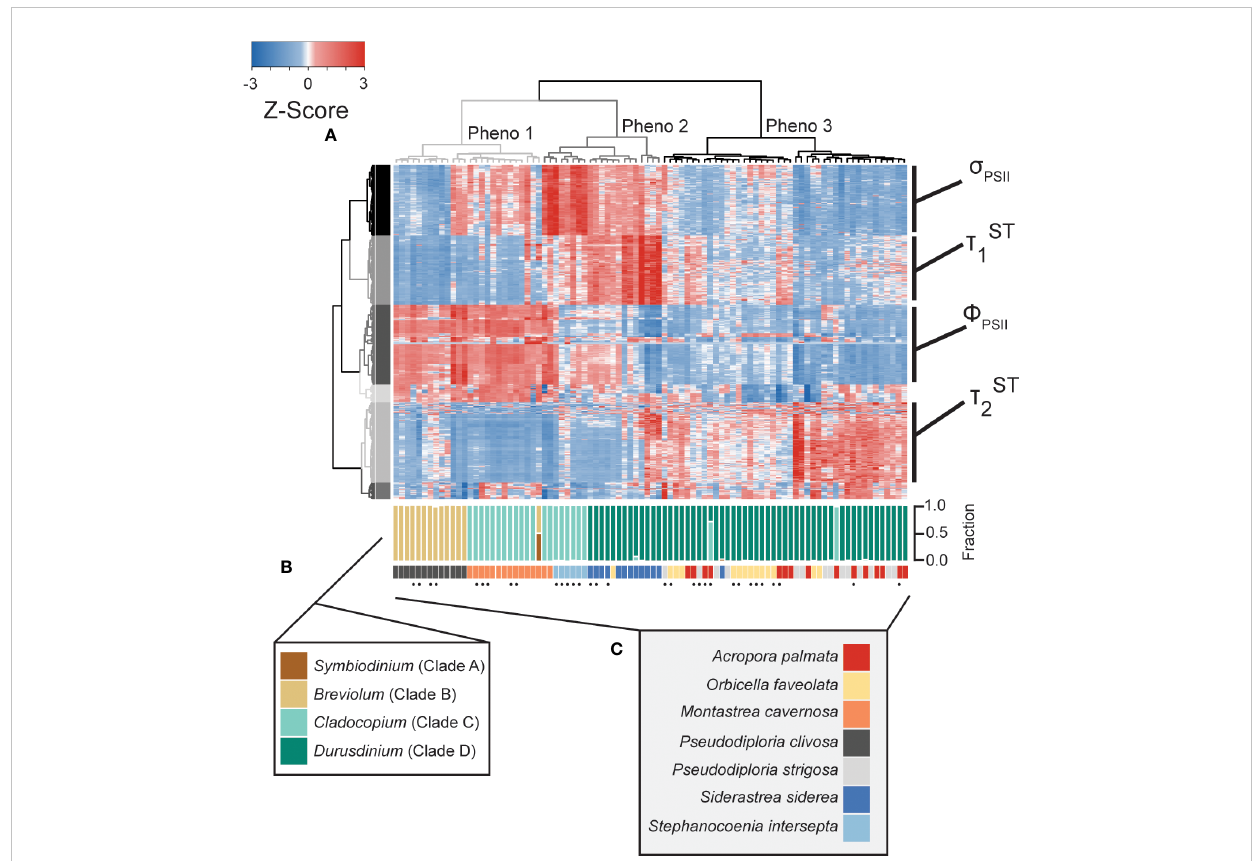
FIGURE 2 Phenotype to clade level comparison. Heatmap (A) re fl ects photo-physiological metrics collected using our multispectral and single-turnover instrument. Of the 1360 metrics measured, the heatmap represents only the 594 signi fi cantly different metrics across symbiont genera. Each row re fl ects a separate algal biometric displayed as standard deviation from the mean (z-score). Sample order was determined through hierarchical clustering re fl ected through the column dendrogram which identi fi es three distinct phenotypes (grey=1, dark grey=2, and black=3). Row order was also determined through hierarchical clustering generating 6 separate clusters indicated by colors. Dominant photo-physiological metrics within selected row clusters (four largest clusters) are indicated to the right of the heatmap. qPCR-based estimates for the proportion of Symbiodiniaceae genera within each sample are re fl ected in the upper barplot (B) . Host coral species is re fl ected in the lower barplot (C) . Replicate fragments from a single genet (within each species) are indicated by black